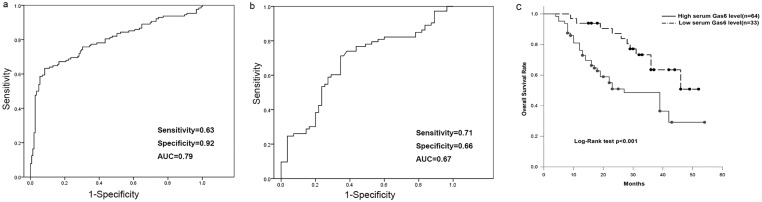
Receiver operating characteristic curves of serum Gas6 for differentiating OSCC patients from normal controls (a); receiver operating characteristic curves of serum Gas6 for differentiating OSCC patients with late stage (III, IV) from those with early stage (I, II) (b); Kaplan—Meier overall survival curve of OSCC patients in correlation with serum Gas6 level (c).